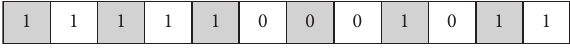
Figure 1: Schematic representation of a chromosome: 1 � selected features; 0 � unselected